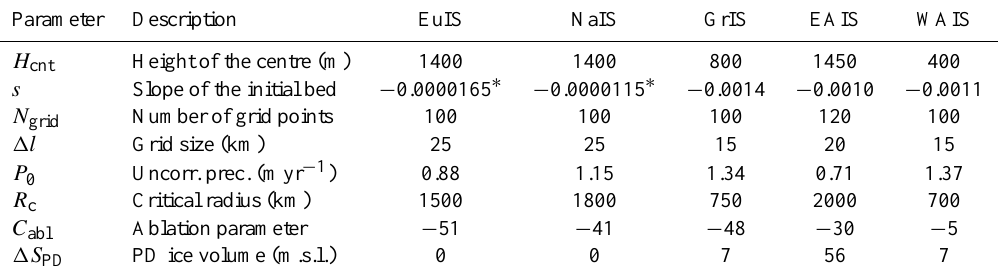
Table 2. Model parameters for the ISM.